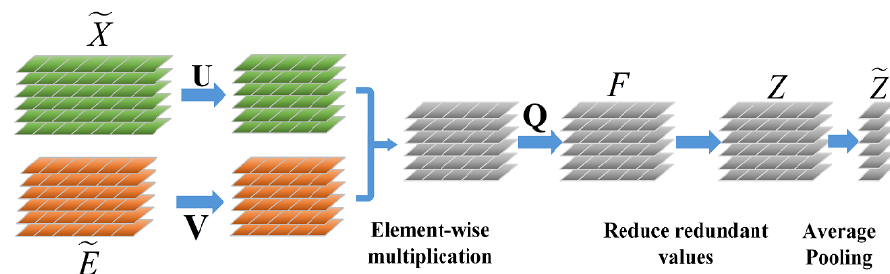
Figure 5. The architecture of the FBE